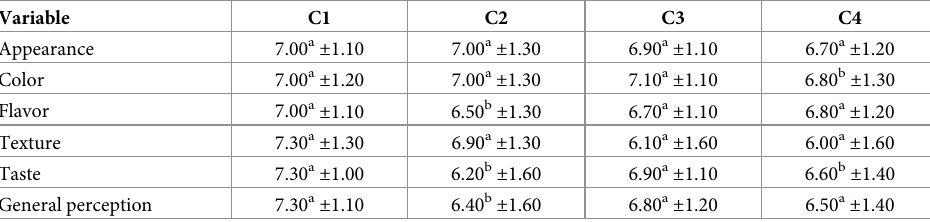
Table 5. Acceptance scores and preference of the